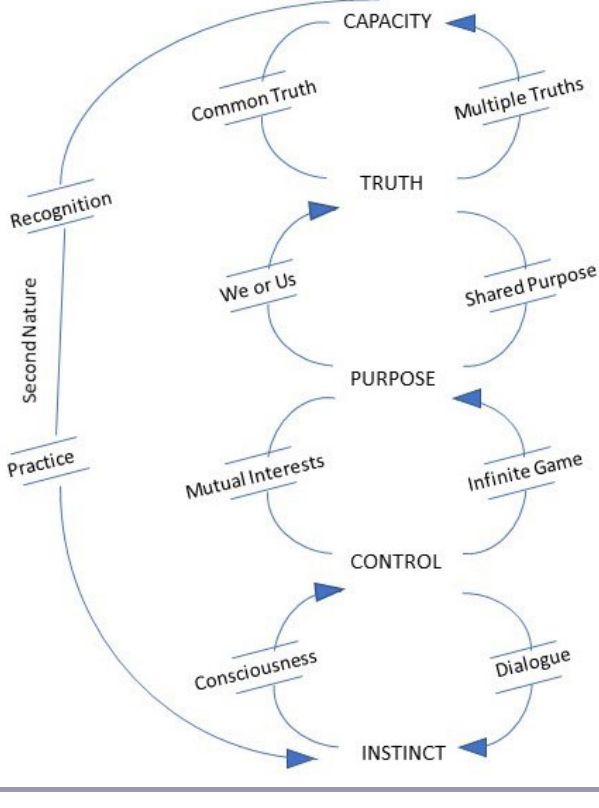
Fig. 2. The capacity of any person, organization, or community is dynamic and increases or decreases within a system. The alignment of the system structures creates the potential for transformation and increased capacity. Transformation requires breaking through the glass ceiling and then working to break the cycle to create a new dynamic. The increased capacity can become the new norm through recognition and